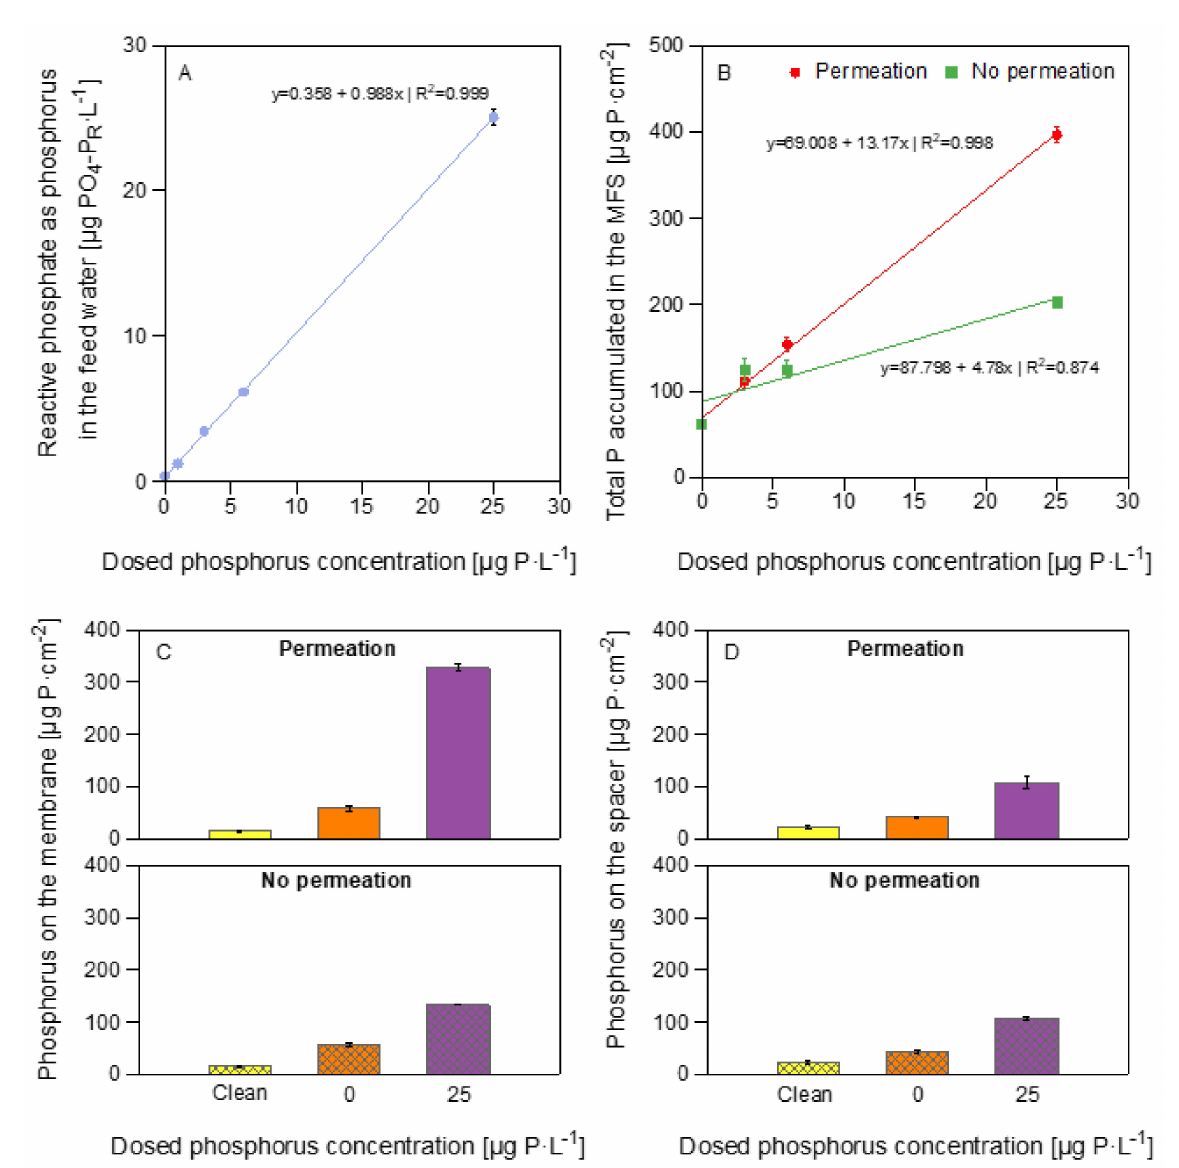
Figure 8. Reactive phosphorus concentration in the feed water and phosphorus concentrations on the MFSs. ( A ) XY scatter plot of the reactive phosphorus concentration in the feed water at different dosed phosphorus concentrations (0, 1, 3, 6, and 25 µ g P · L − 1 ) determined by a segmented flow analyzer. ( B ) XY scatter plot of the total accumulated phosphorus concentration in the MFS for permeation and non-permeation conditions determined by inductively coupled plasma atomic emission spectroscopy (ICP-OES) after 4.7 days of system operation. The dots represent the experimental data. The lines represent the fitted model. Phosphorus concentration accumulated on ( C ) the membrane, and ( D ) the spacer for the MFSs at varying dosed phosphorus concentrations (0 and 25 µ g P · L − 1 ) and a dosed assimilable organic carbon concentration of 250 µ g C · L − 1 in the feed water. The error bars represent the data of independent triplicate MFS